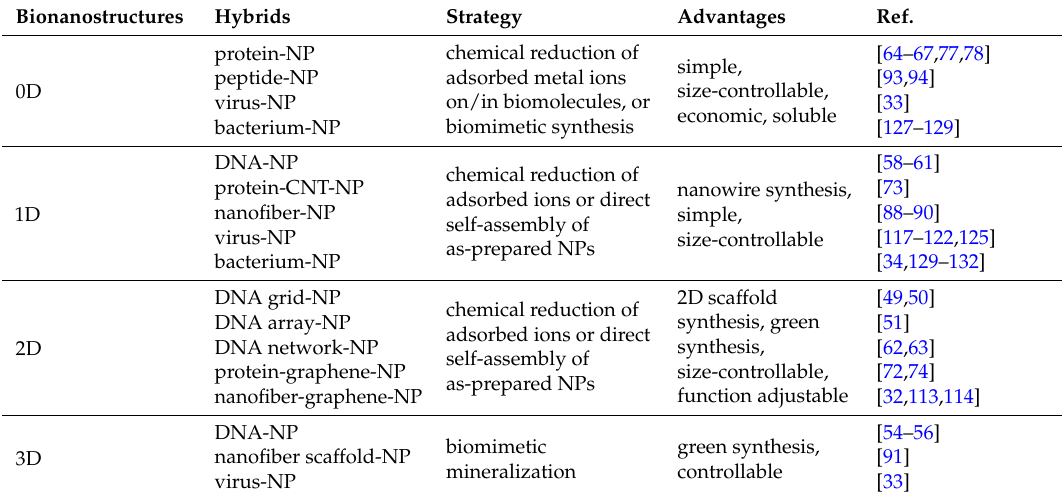
Table 1. Synthesis strategies for the biomimetic hybrid nanomaterials.